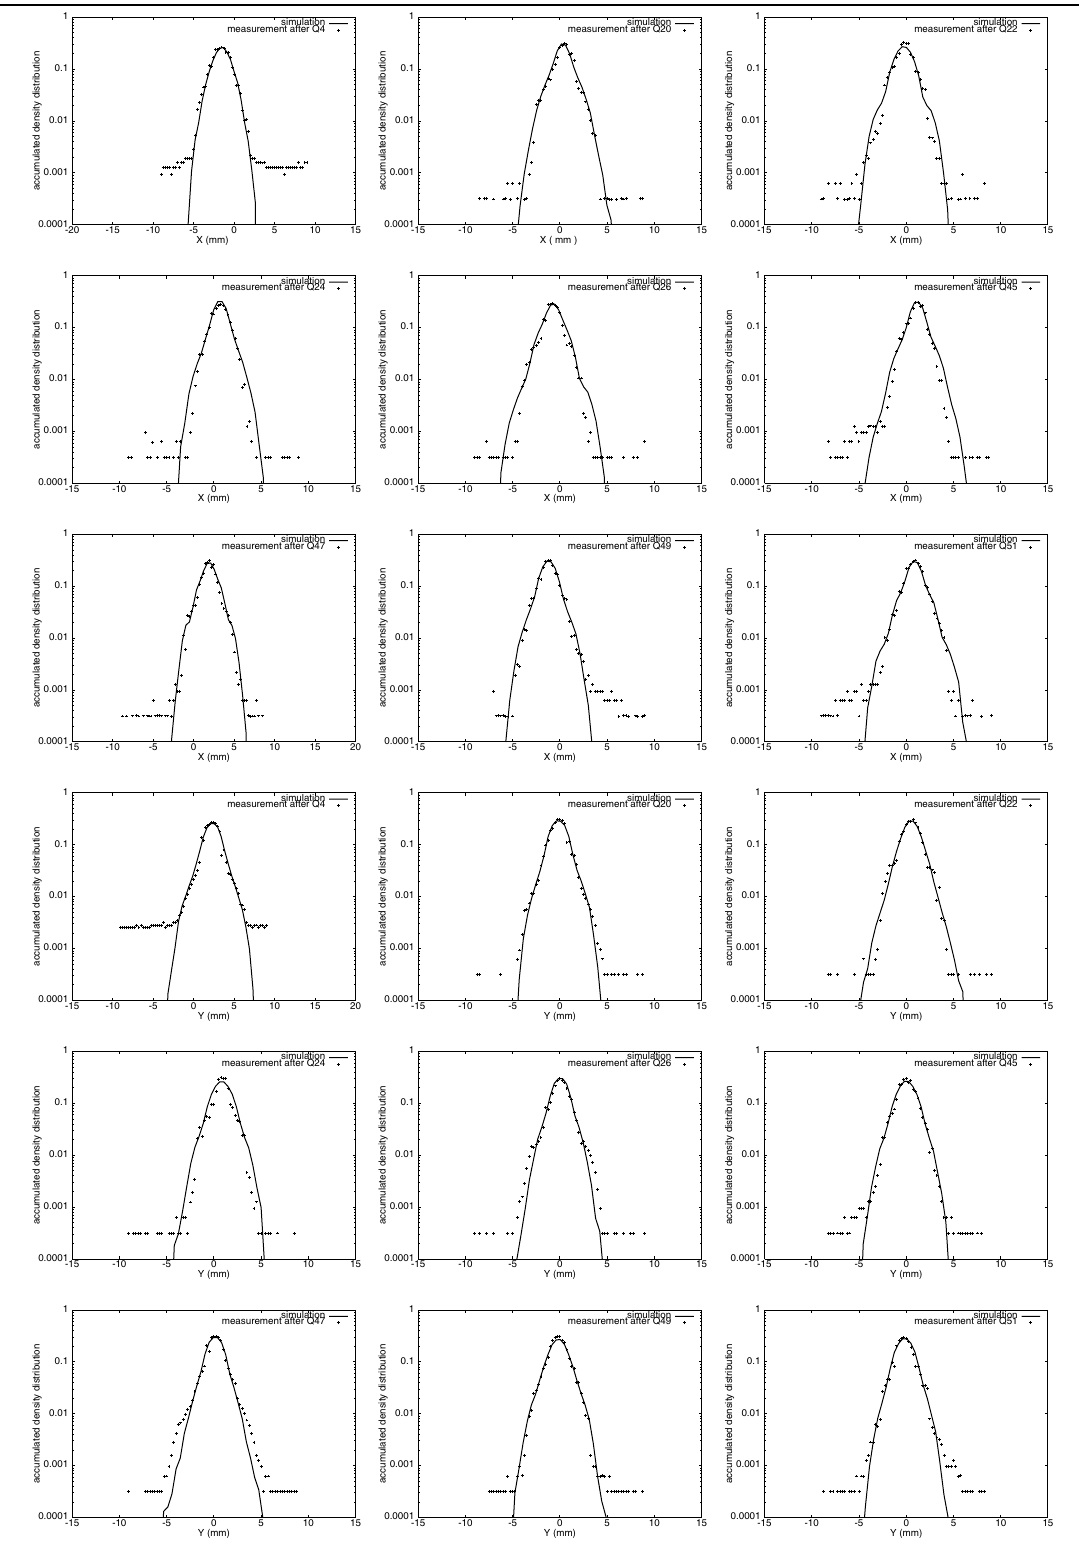
FIG. 6. X and y density distribution from simulation using initial scaled LEBT/RFQ distribution and from measurements at 75 mA matched case. The first nine plots correspond to the nine x profiles and the second nine plots correspond to the nine y